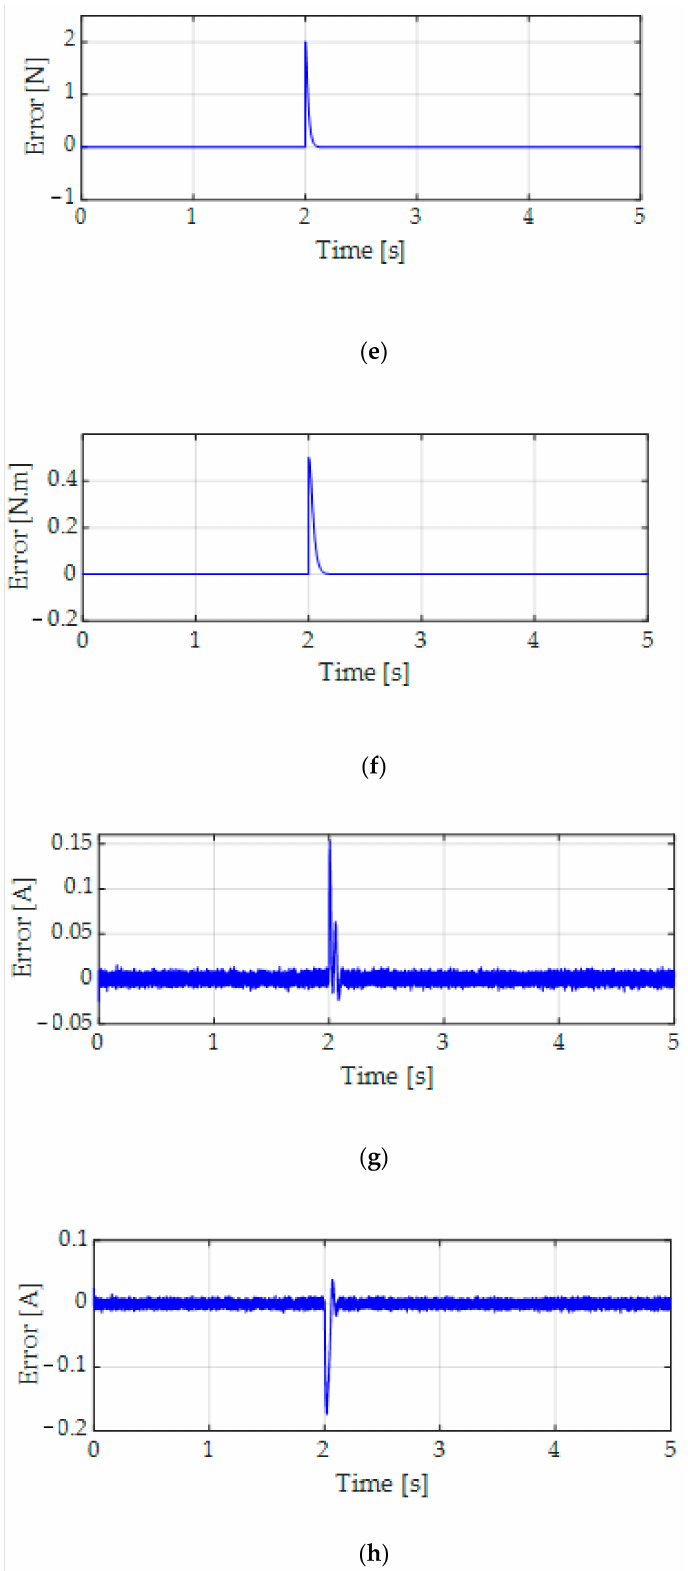
Figure 7. Estimation error performance of the proposed ANOB. ( a ) Estimation error performance of (cid:101) θ x . ( b ) Estimation error performance of (cid:101) θ y . ( c ) Estimation error performance of (cid:101) θ yaw . ( d ) Estimation error performance of (cid:101) d x . ( e ) Estimation error performance of (cid:101) d y . ( f ) Estimation error performance of (cid:101) d yaw . ( g ) Estimation error performance of (cid:101) i x 1 a . ( h ) Estimation error performance of